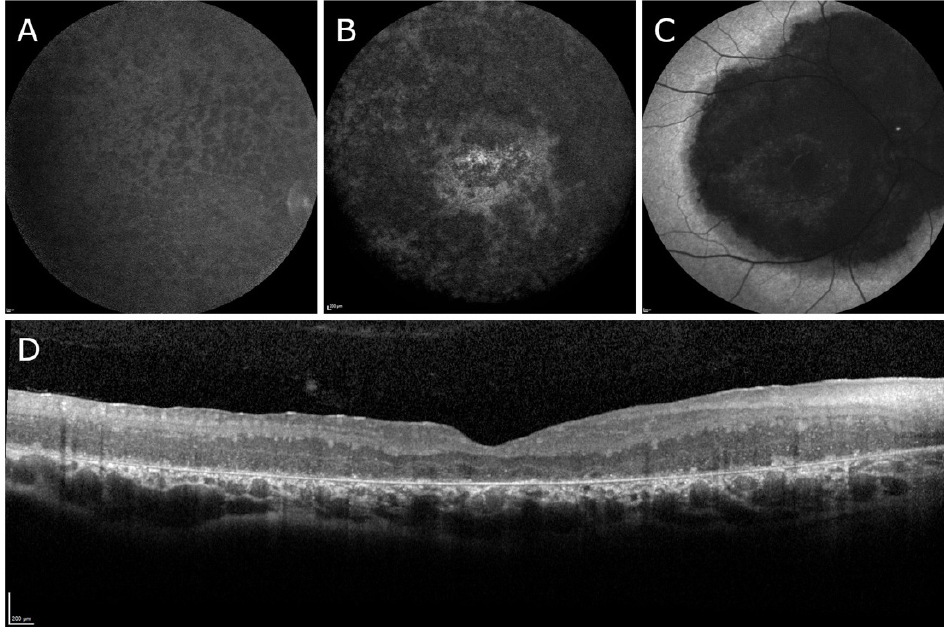
Figure 2. Short-wavelength autofluorescence (SW-AF) for three patients with at least one confirmed mutation in the top ten most prevalent variants of CRB1 and representative spectral domain optical coherence topography (SD-OCT) imaging of patients with two mutations in CRB1 . ( A , B ) Two SW-AF images from patients 3 and 7, respectively, representative of typical SW-AF presentation in patients with confirmed CRB1 mutations. There is globally diminished autofluorescence with overlying heterogeneous pattern of hypoautofluorescence involving the posterior pole and peripheral retina. ( C ) SW-AF of patient 6 showing central atrophy in the macula extending nasally past the optic nerve, superiorly greater than inferiorly. ( D ) SD-OCT imaging from patient 2 representative of typical SD- OCT presentation in patients with confirmed CRB1 mutations. Retinal layers are poorly